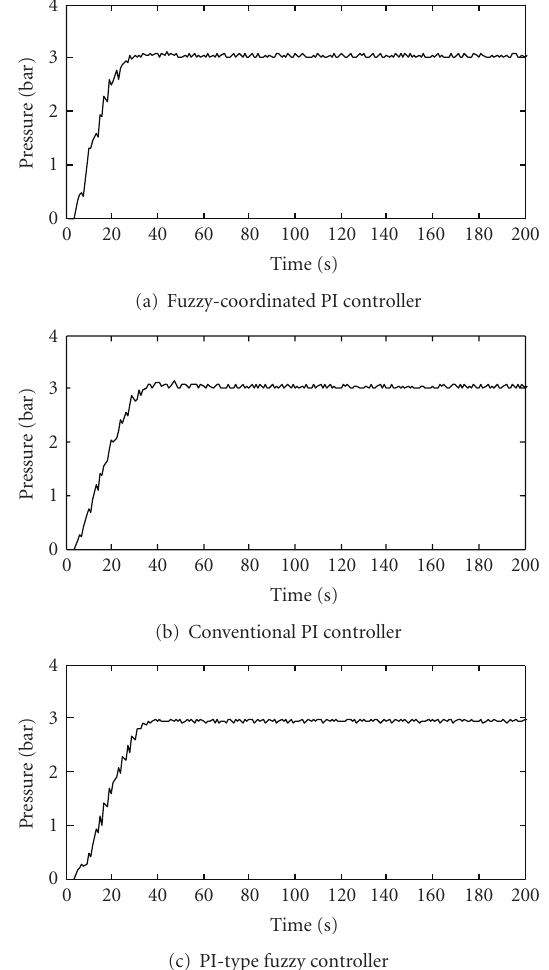
Figure 9: Experimental results, output responses of di ff erent controllers for the set pressure level of